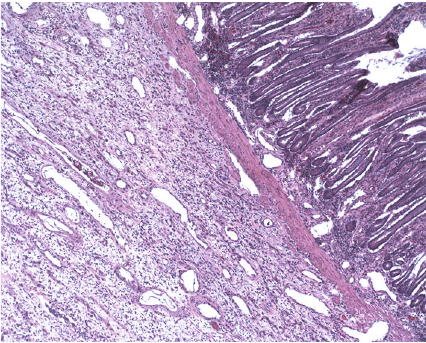
Figure 9: Low power of inflammatory fibroid polyp with overlying benign bowel mucosa (5x).